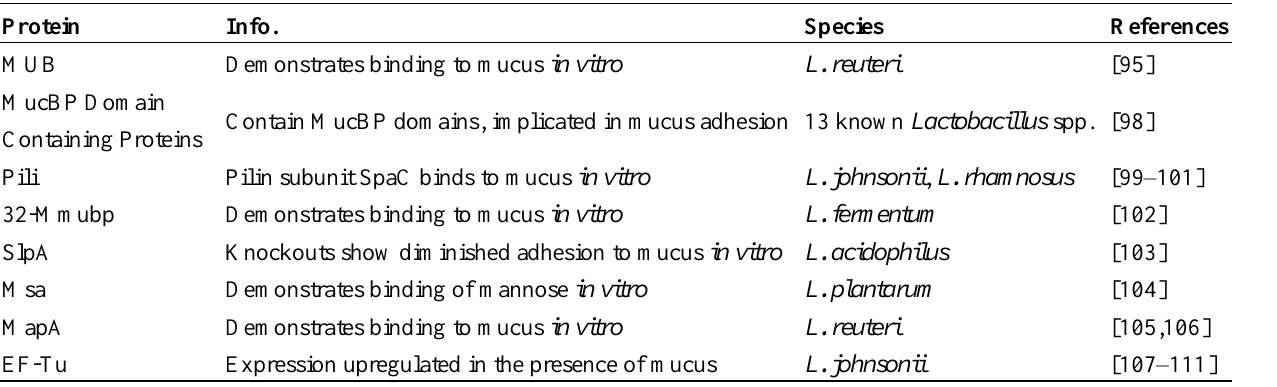
Table 2. Adhesion promoting proteins in Lactobacillus spp.